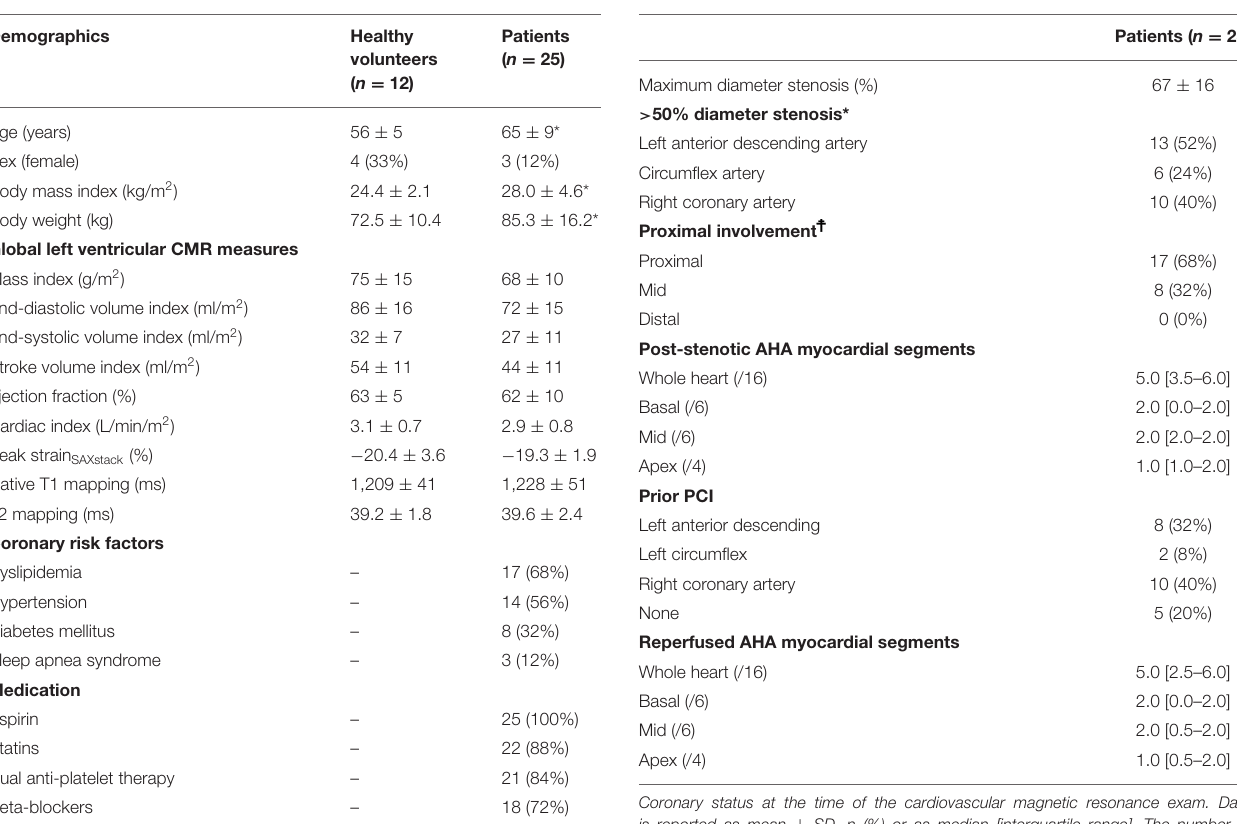
TABLE 1 | Patient characteristics. TABLE 2 | Coronary